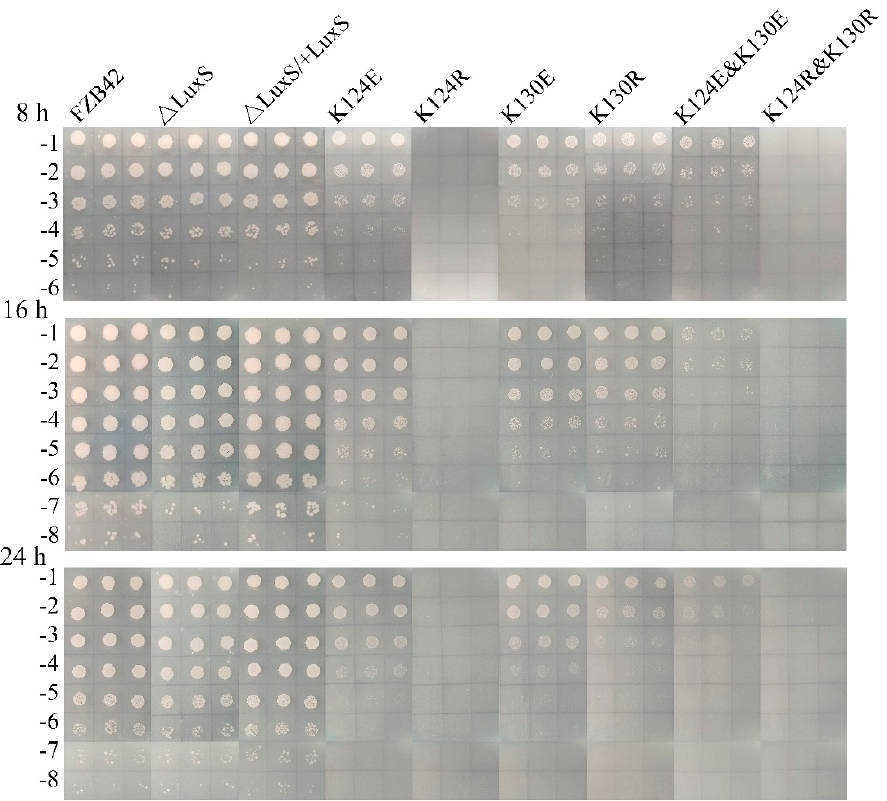
Figure 4. Quantification of sporulation in FZB42 wild type and its mutants. The strains were grown in LB for the time indicated before being subjected to heat treatment. The culture was serially diluted five times. Three microliter aliquots of the cultures were spotted onto LB agar and incubated at 37 °C for 10 h.